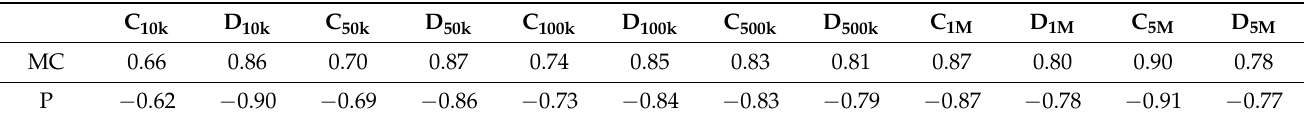
Table 2. Pearson correlation coefficients between measured electrical capacity (C), dissipation factor (D), moisture content (MC) and porosity (P) at different frequencies.